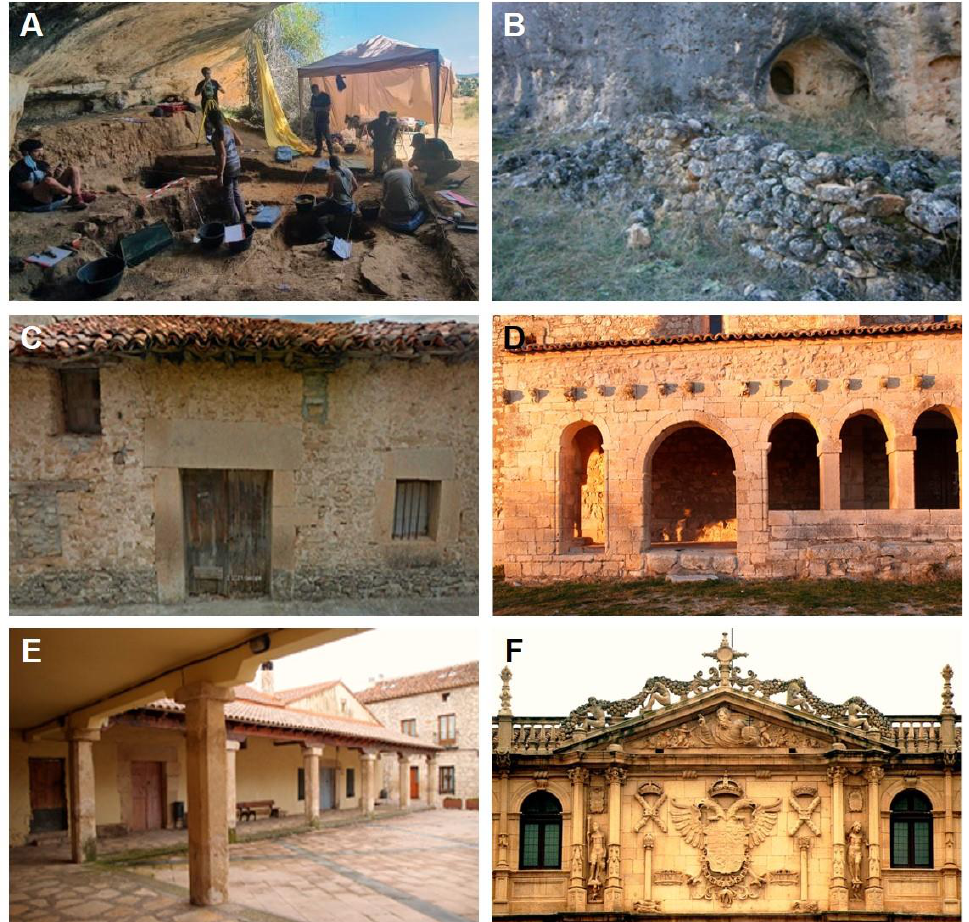
Figure 3. ( A ) Archaeological excavation campaign in the “Abrigo de la Malia” site of Tamajón (Gua- dalajara, Spain); ( B ) Image of one of the karstic caves of the “Ciudad Encantada” of Tamajón, inhab- ited since the Upper Palaeolithic, with a stone fence placed in front of its access; ( C ) View of a house in Tamajón, which has retained traditional spatial divisions and construction methods; ( D ) Image of the portico of the “Iglesia de Nuestra Señora de la Asunción”, a church in Romanesque style, showing the characteristic appearance of Tamajón Stone; ( E ) View of the portico of the main square “Plaza Mayor” of Tamajón with columns that show the suitability of the Tamajón Stone for obtain- ing uniform blocks; ( F ) Detail of the main facade of the “Colegio de San Ildefonso” college (Alcalá de Henares, Spain), current seat of the Rectorate of the University of Alcalá and an example of the